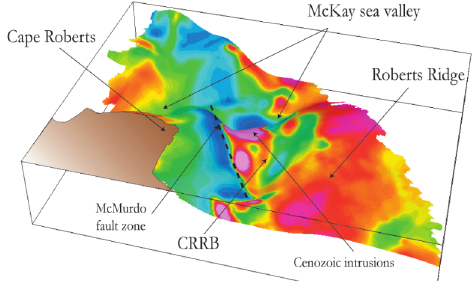
Fig. 3. Modal 3D view of CRRB with draped mag- netic anomaly overprinted.